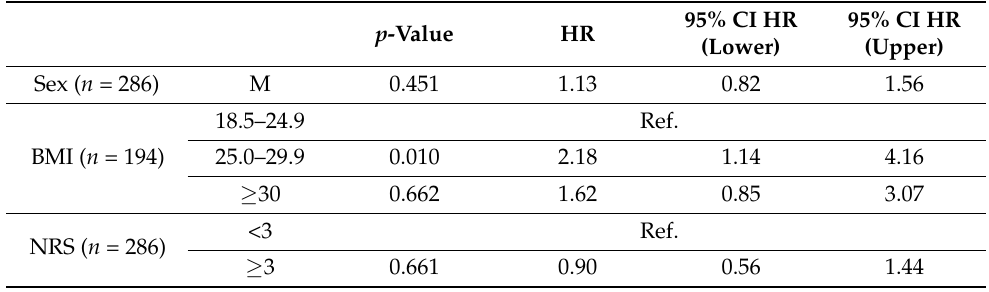
Table 8. Assessment of the influence of variables on mortality: the Cox proportional hazards regression model, a single model.